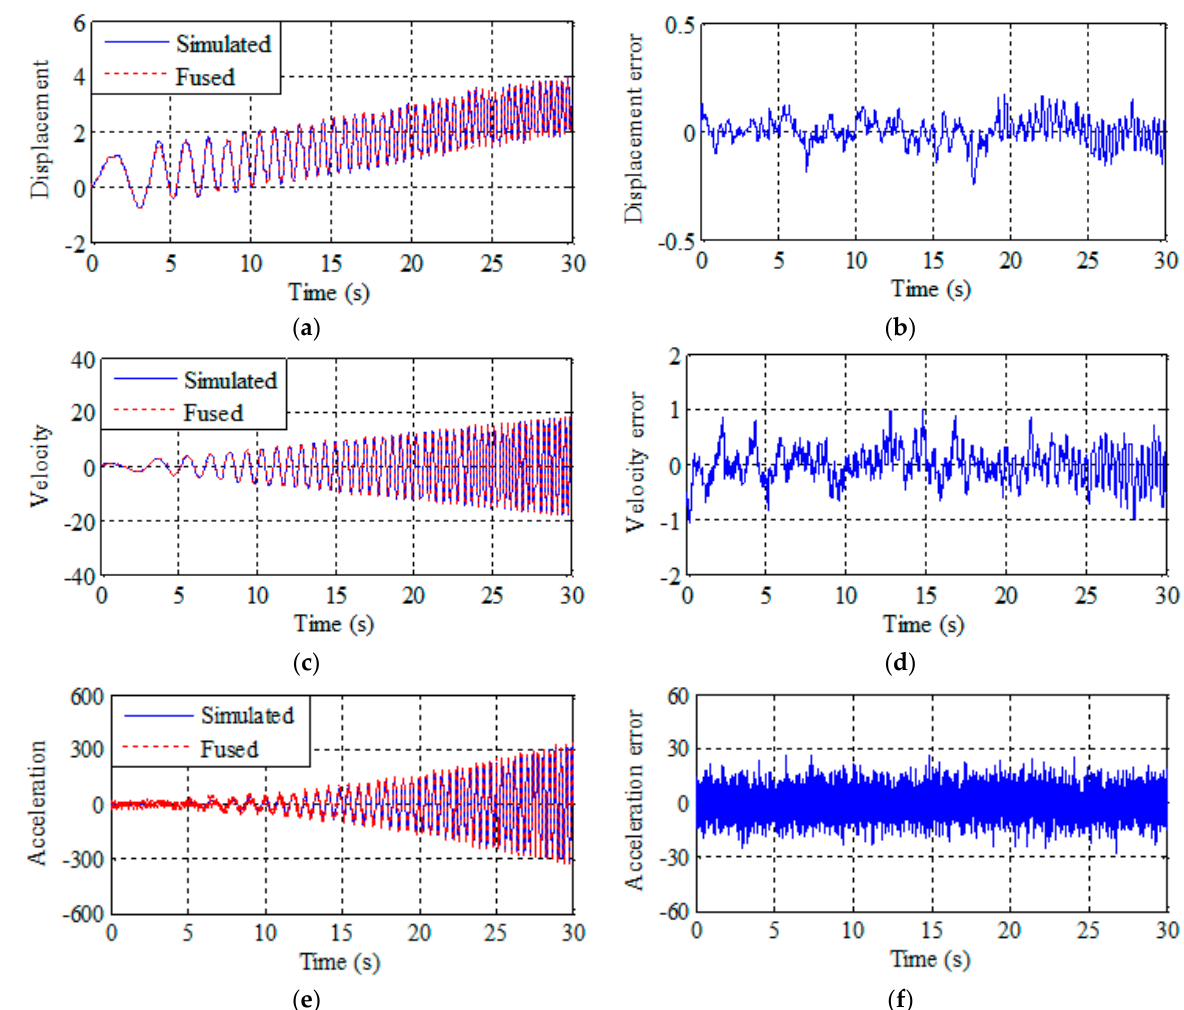
Figure 2. Improved multi-rate fusion and estimation error of displacement, velocity, and acceleration. ( a ) Displacement improved multi-rate fusion. ( b ) Displacement error. ( c ) Velocity improved multi-rate fusion. ( d ) Velocity error. ( e ) Acceleration improved multi-rate fusion. ( f ) Acceleration error. Table 1. Root mean square error (RMSE) of improved multi-rate Kalman fusion and smoothing results.